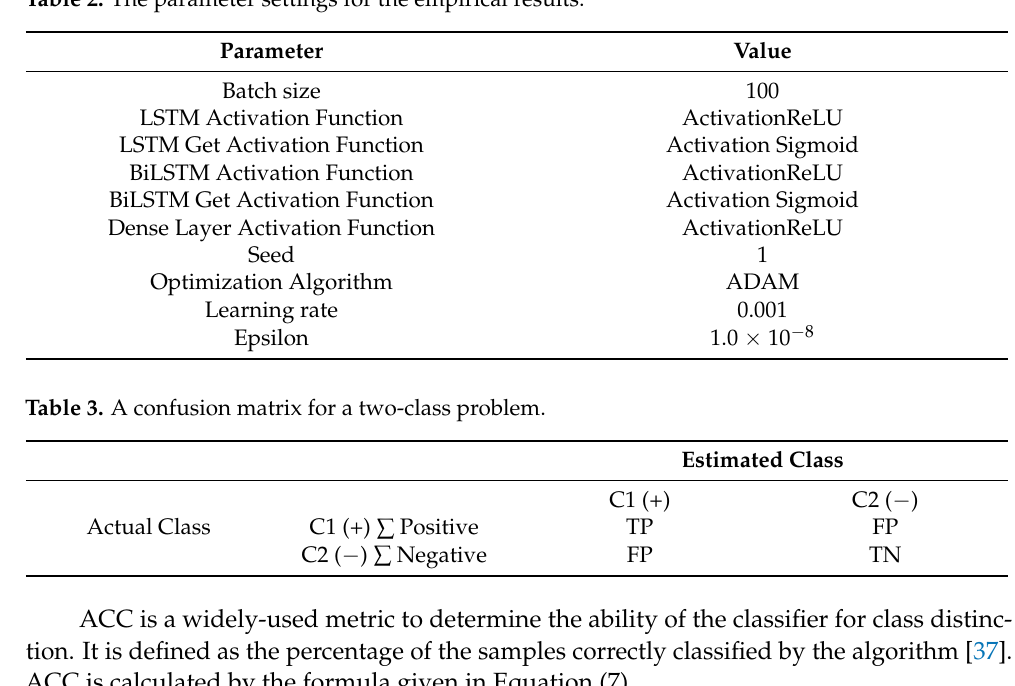
Table 2. The parameter settings for the empirical results.